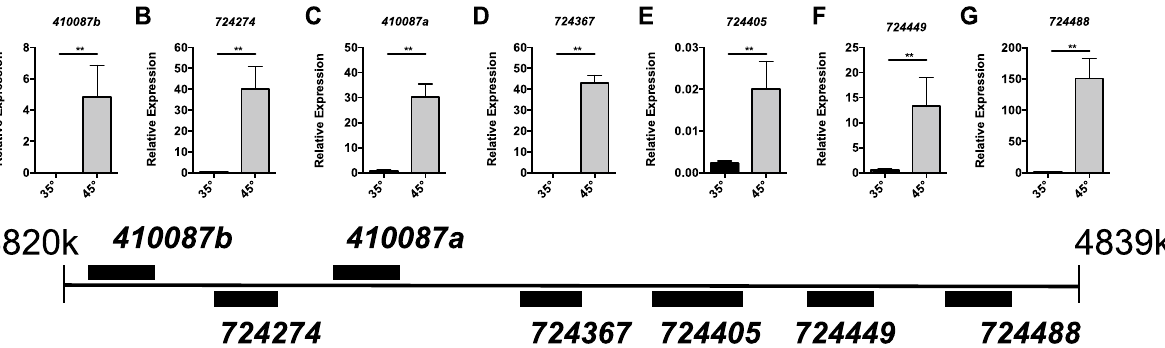
Figure 4. Select sHSP genes are induced during Heat-Shock. Transcript levels of the l(2)efl genes 410087b ( A ), 724274 ( B ), 410087a ( C ), 724367 ( D ) , 724405 ( E ), 724449 ( F ), and 724488 ( G ) after heat shock relative to β-actin in midgut tissue from adult bees captured at the landing board and maintained for 4 h in cages at either 35° (n = 6) or 45 °C (n = 6). A schematic diagram of the colocalized l(2)efl genes in the honey bee genome is shown below for reference. Mean ± SEM is shown and represents expression values of the genes of interest calculated using the 2 (−ΔCT) method for individual bees. Statistical significance is noted as *p < 0.05, and **p <